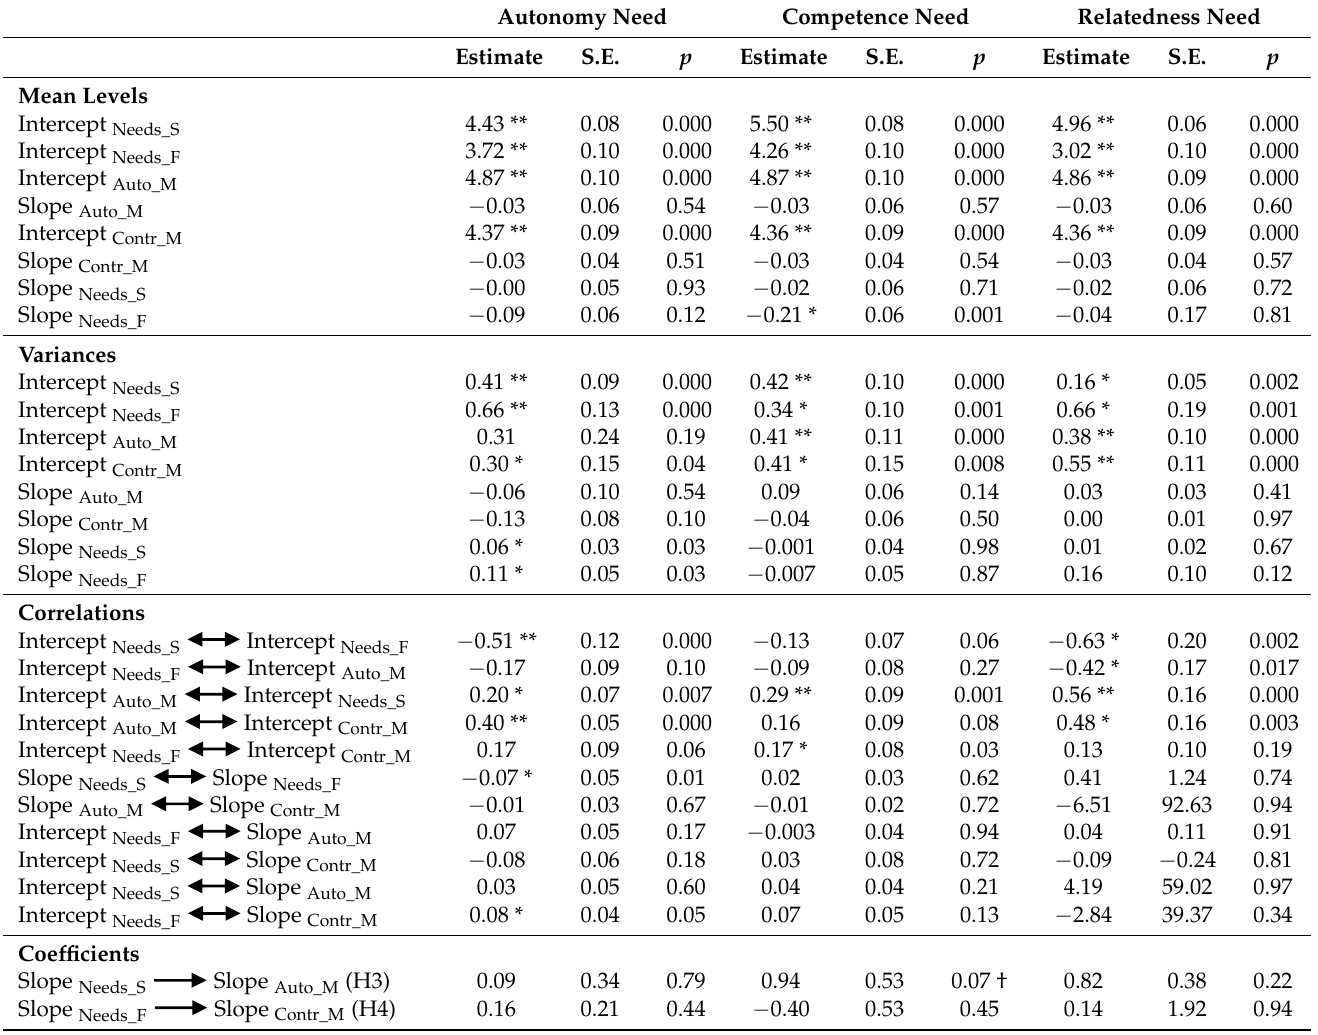
Table 5. Parameter Estimates for LGM Models: Needs Satisfaction/Frustration and Autonomous/ Controlled Motivation.